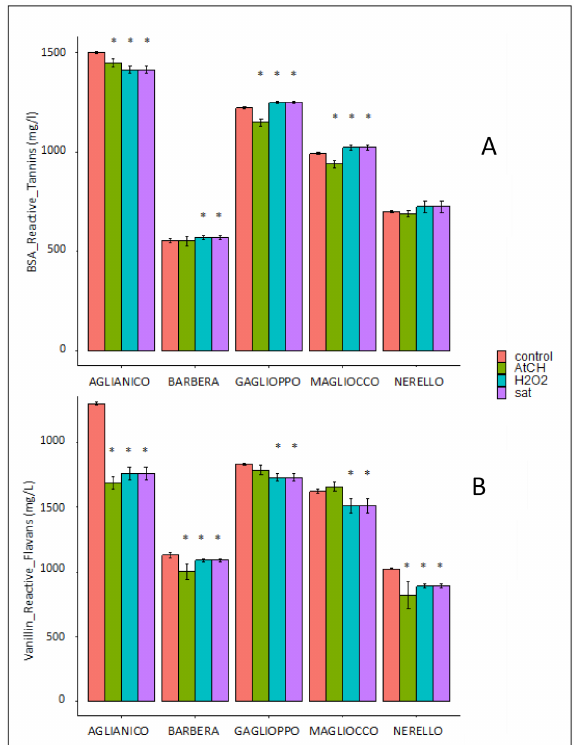
Figure 2. Tannins content in treated wines (Aglianico; Barbera; Gaglioppo; Magliocco; Nerello; Mascalese); ( A ) BSA reactive tannins (mg/L), ( B ) vanillin reactive flavans (mg/L) content in wines before and after treatments. Asterisks (*) indicate significant differences between treated wine and its control ( p -value less than